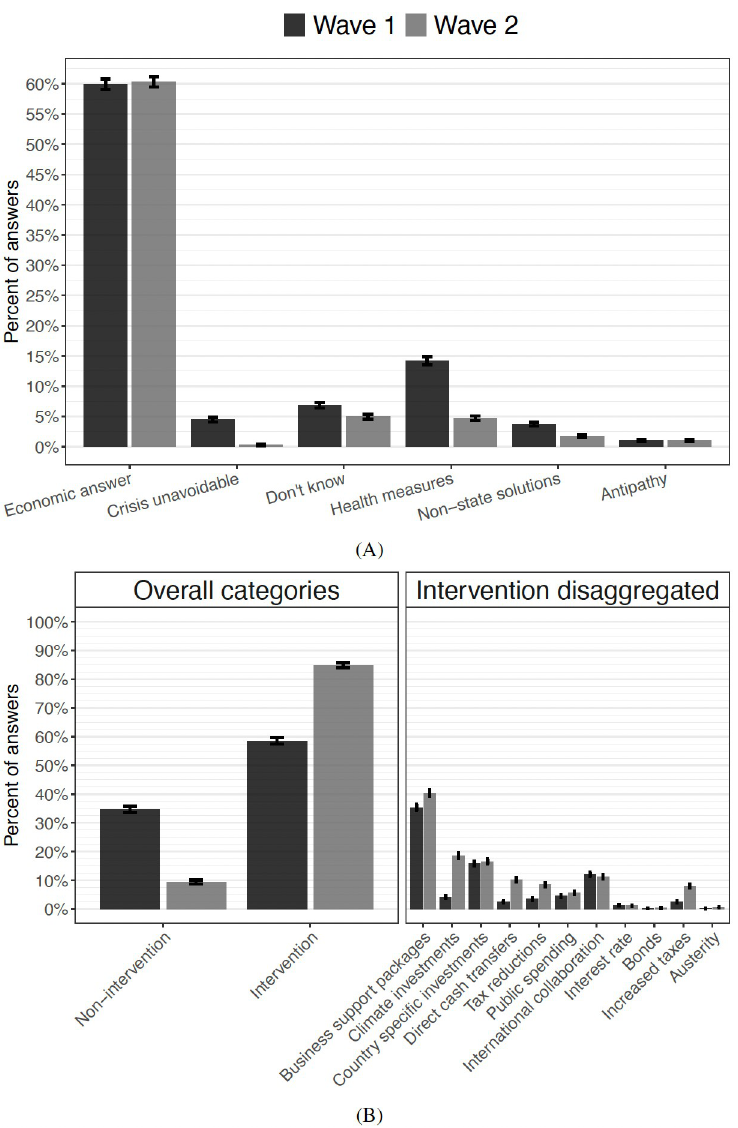
Fig 3. Panel A: Distribution across answer categories (all subjects). Panel B: Intervention vs. non-intervention and types of policy intervention (subjects providing economic answer). Lines are 95% confidence intervals.